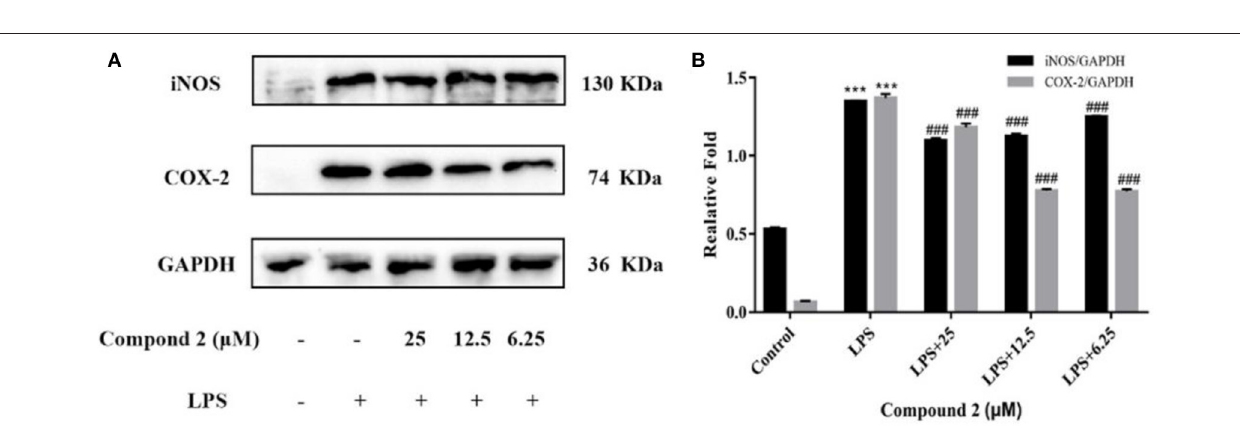
FIGURE 6 | Influences of compound 2 on iNOS, COX-2, and GAPDH protein expression were detected by Western blotting (A) . The ratio of the content of iNOS/GAPDH and COX-2/GAPDH (B) . Data rendered are the mean ± SD, n = 3. In comparison to the control, *** P < 0.001. In comparison to the LPS group, ### P <